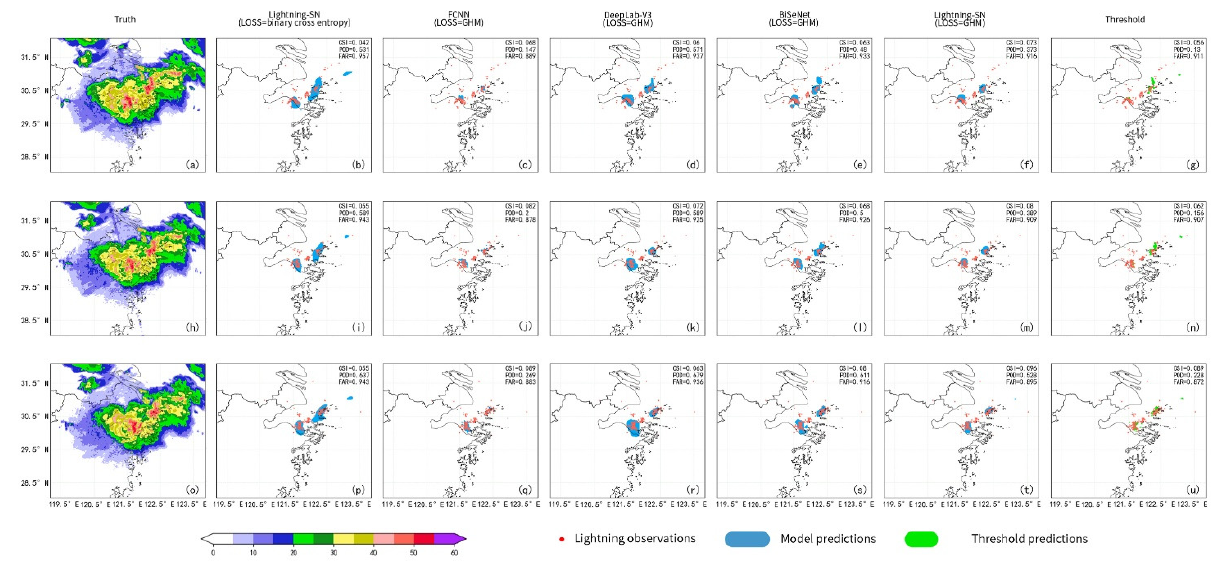
Figure 6. Lightning identification results from 0:36 to 0:54 on 11 May 2021 based on ( a , h , o ) radar composite reflectivity; ( b , i , p ) the Lightning-SN algorithm (LOSS = binary cross entropy); ( c , j , q ) the FCNN algorithm (LOSS = GHM); ( d , k , r ) the DeepLab-V3 algorithm (LOSS = GHM); ( e , l , s ) the BiSeNet algorithm (LOSS = GHM); ( f , m , t ) the Lightning-SN algorithm (LOSS = GHM); and ( g , n , u ) the threshold method in the ( a – g ) 0:36–0:42, ( h – n ) 0:42–0:48, and ( o – u ) 0:48–0:54 radar volume scanning period.